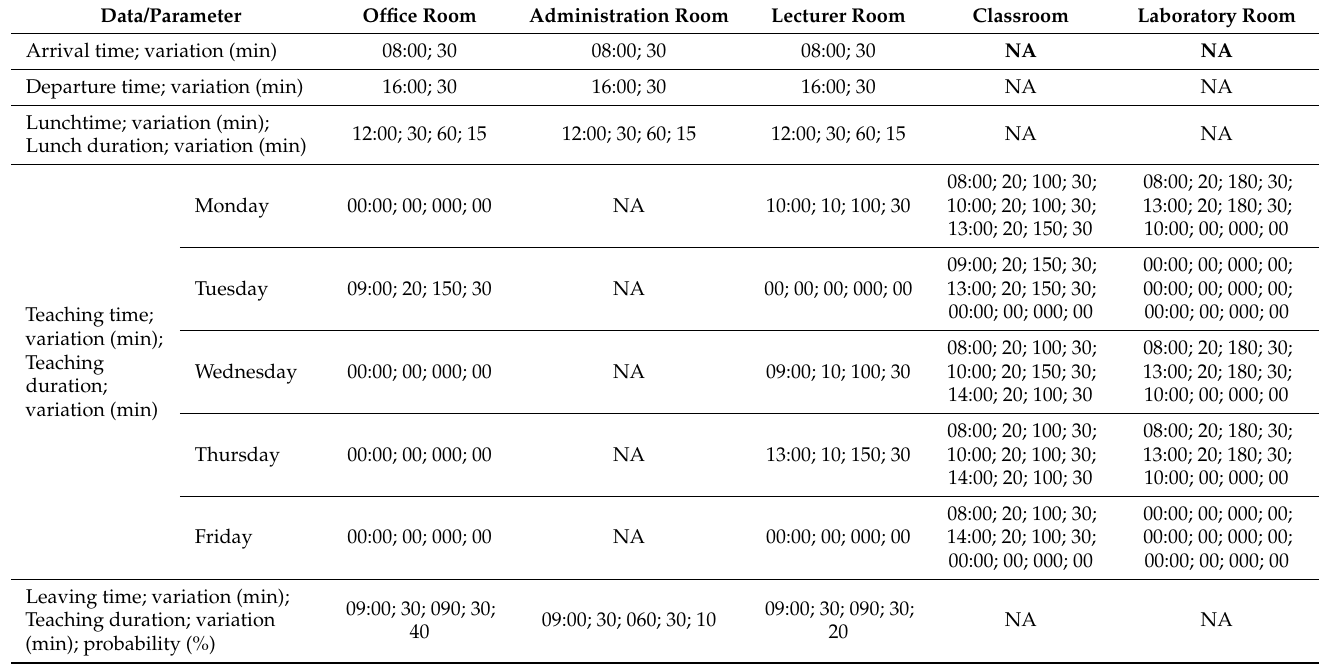
Table 4. Data and parameters of the